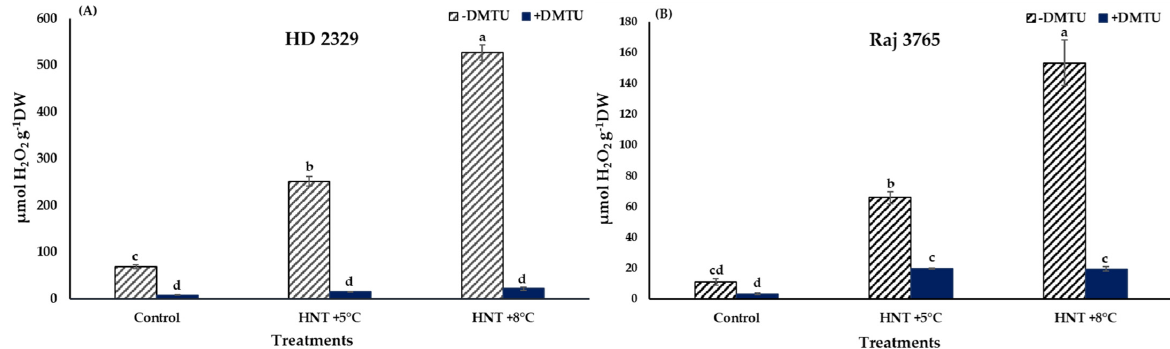
Figure 4. Effect of HNT on hydrogen peroxide content in pistil of wheat genotypes ( A ) HD 2329 (sensitive) and ( B ) Raj 3765 (tolerant) under control, HNT (+5 °C) and HNT (+8 °C) conditions in absence and presence of ROS scavenger (DMTU). Bars represent mean ± SE. Bars with common letter are not significantly different between temperature treatments in a genotype at p < 0.05.